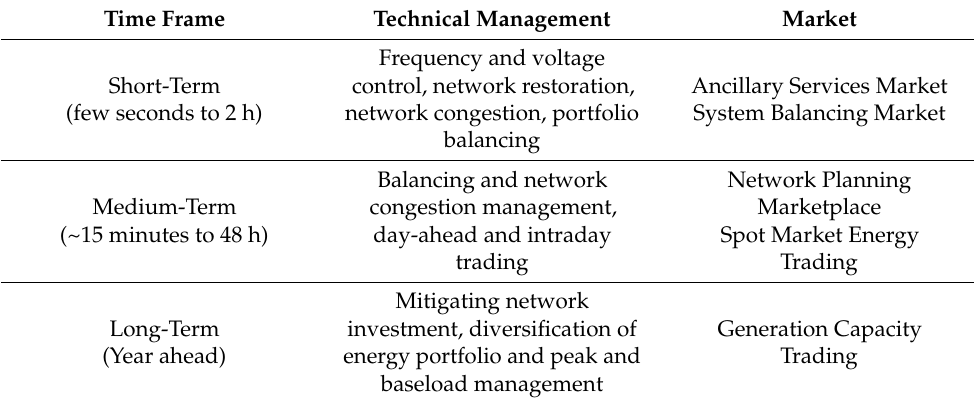
Table 2. Emerging markets in response to distributed energy integration via microgrids.